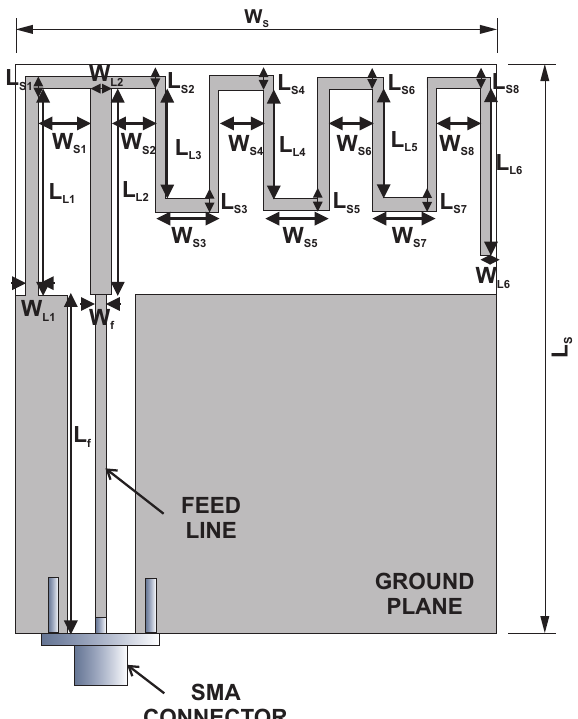
Figure 1. Geometry of the Meander Shape (MS)-Inverted-F Antenna (IFA) considered and the design